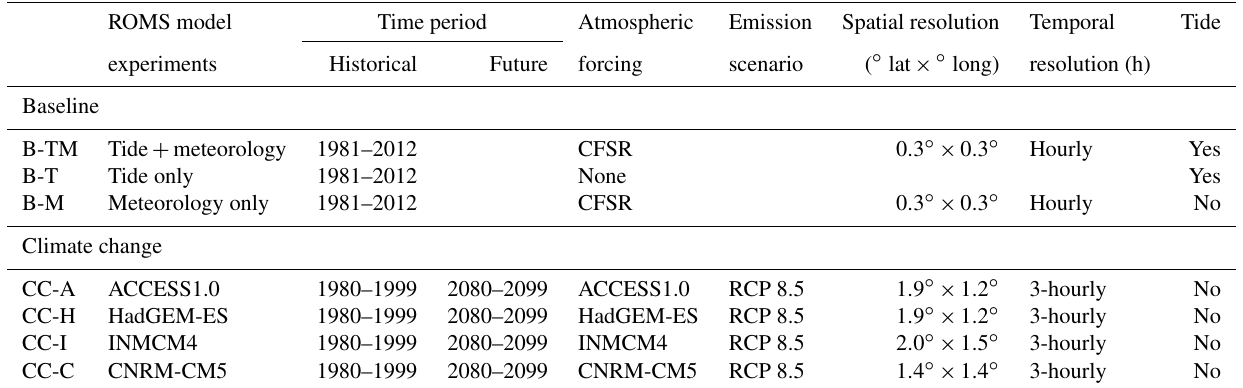
Table 1. Summary of model experiments carried out. The spatial and temporal resolutions refer to the source of the atmospheric forcing applied to the ROMS